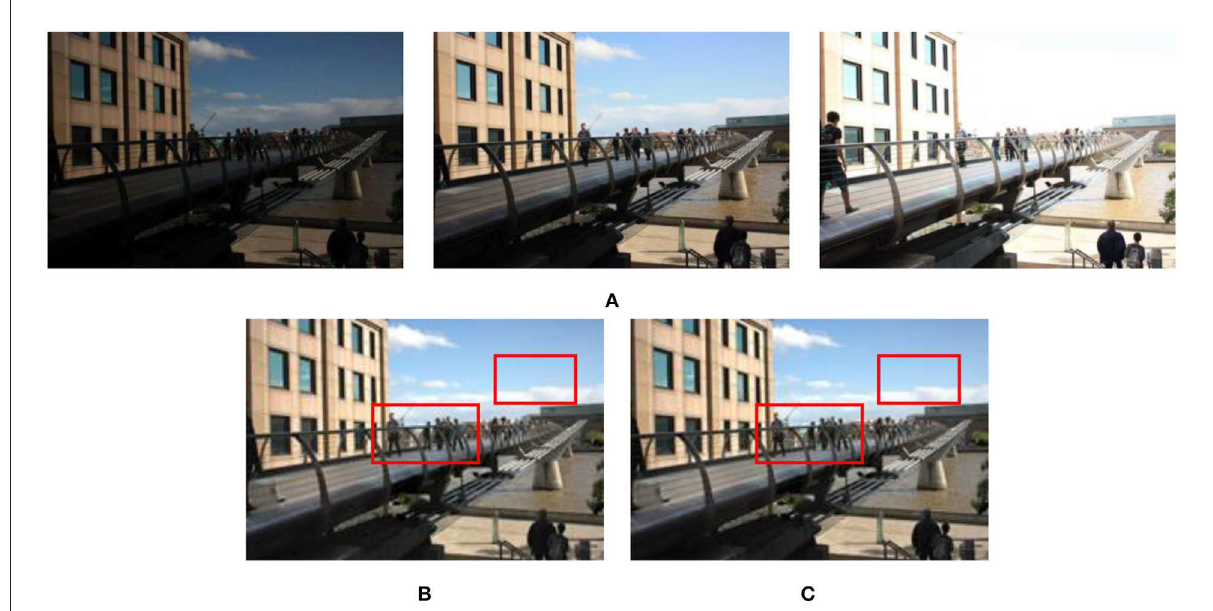
FIGURE5 Experimental results of processing a dynamic scene “Tate” image sequence using the original/improved pyramid model. (A) “Tate” image sequence; (B) using the original pyramid model (Mertens et al., 2007); (C) using the improved pyramid